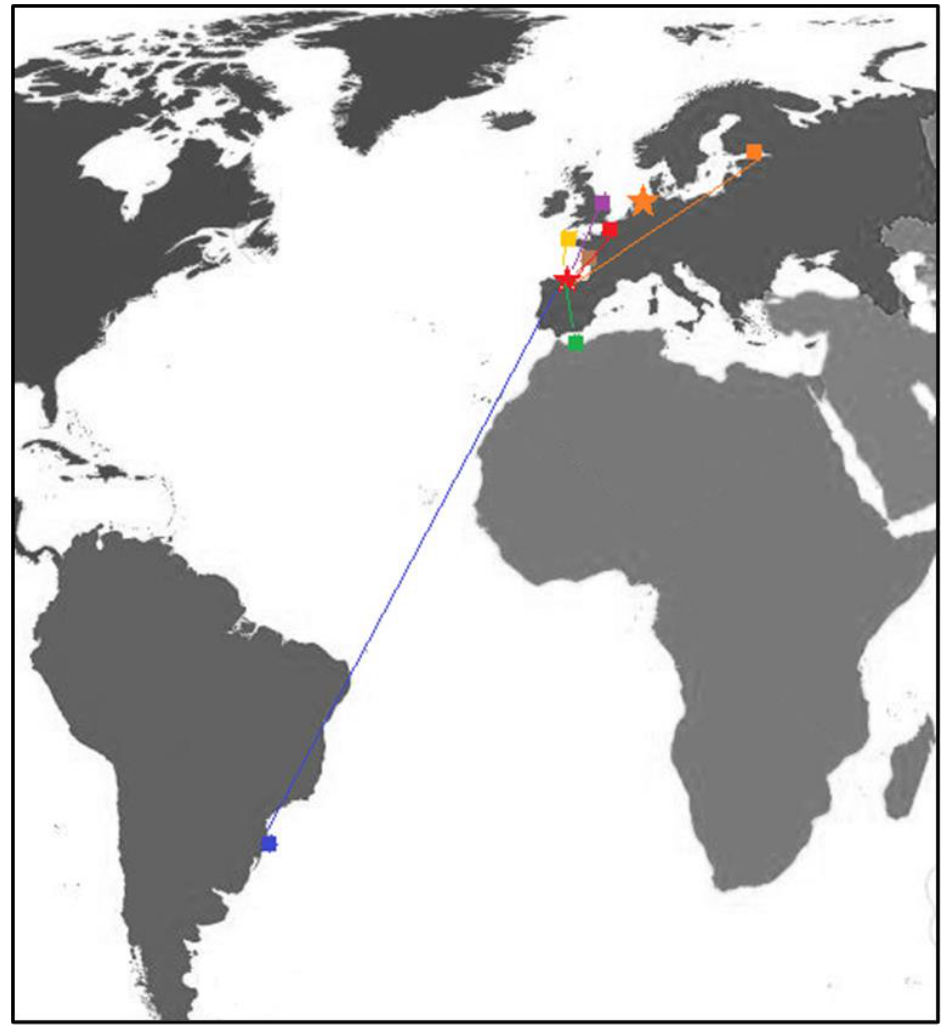
Figure 1. Map showing the ports where the ballast water (BW) was uploaded in the ships analysed. Port of Gijon and Bremerhaven port are marked with a red and orange star, respectively. The ports marked with squares are the ports of origin of the ships arriving in port of Gijon analysed in this study (yellow: Brest, green: Nador, blue: Tubarao, purple: Gunnes Warf, brown: La Pallice-La Rochelle, orange: Vystosk, red: Rotterdam).